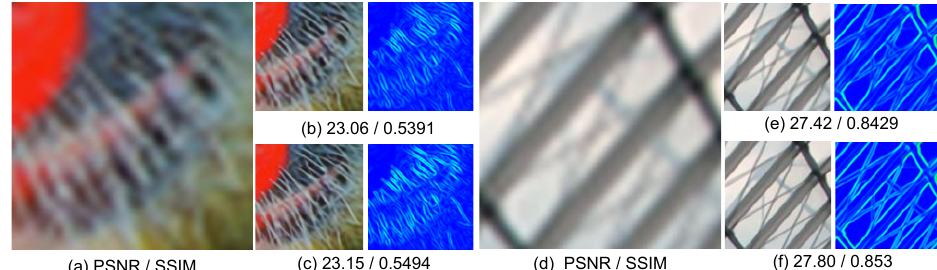
Figure 7. Visual comparison of the baseline with and without the Gradient-Guided Strategy (GGS). We present the LR images, the reconstructed images, and the absolute gradient intensity maps corresponding to the reconstructed images. Among them, ( a , d ) are input LR images, ( b , e ) are recon- structed results of baseline without GGS, and ( c , f ) are reconstructed results of baseline with GGS. The proposed GGS is able to effectively preserve the structure and acquire sharper high-frequency details.